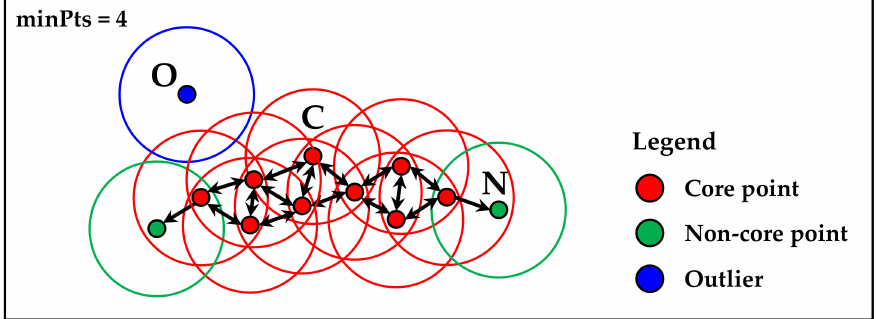
Figure 2. The relationships among key concepts of density-based clustering of application with noise (DBSCAN) (minPts = 4 is used as an